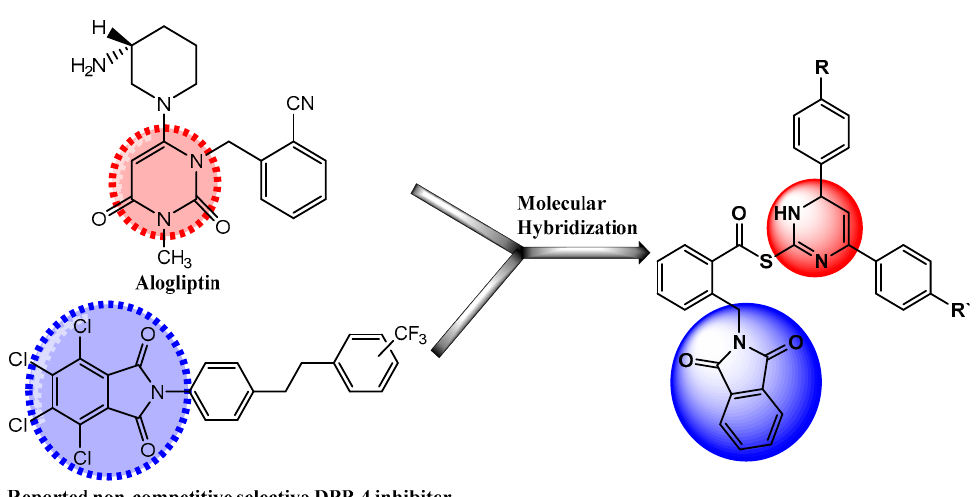
Figure 1. Diagram represents design of novel DPP-4 inhibitors.